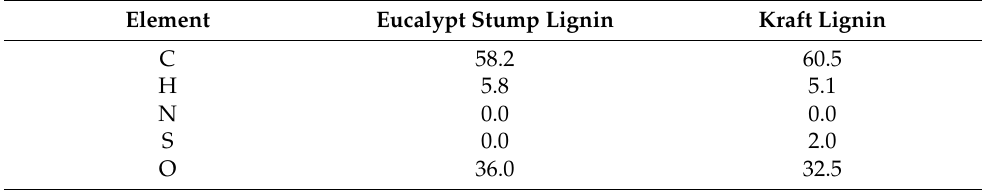
Table 2. Results of the elemental analysis of the isolated lignins (mass percentage).